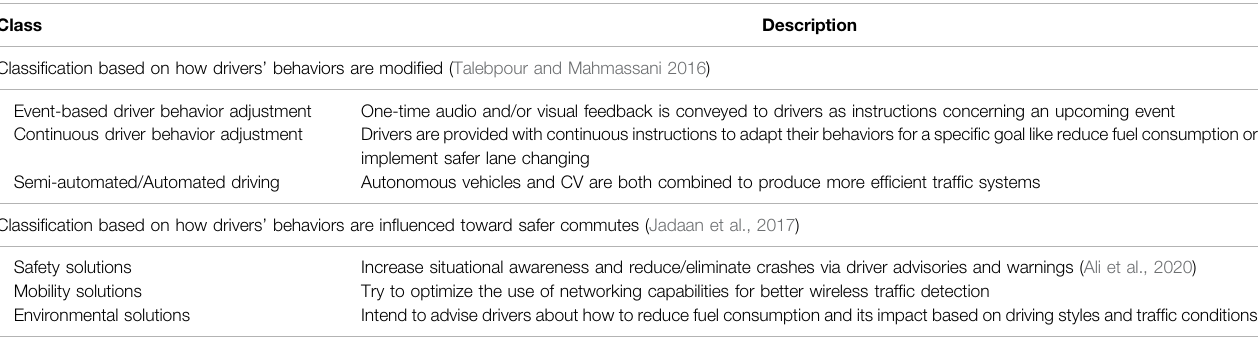
TABLE 1 | Classi fi cation of the impact of CV solutions on driving behaviors. Class Description